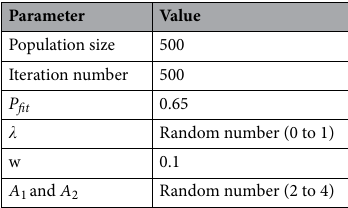
Table 2. Parameters of HCO algorithm.